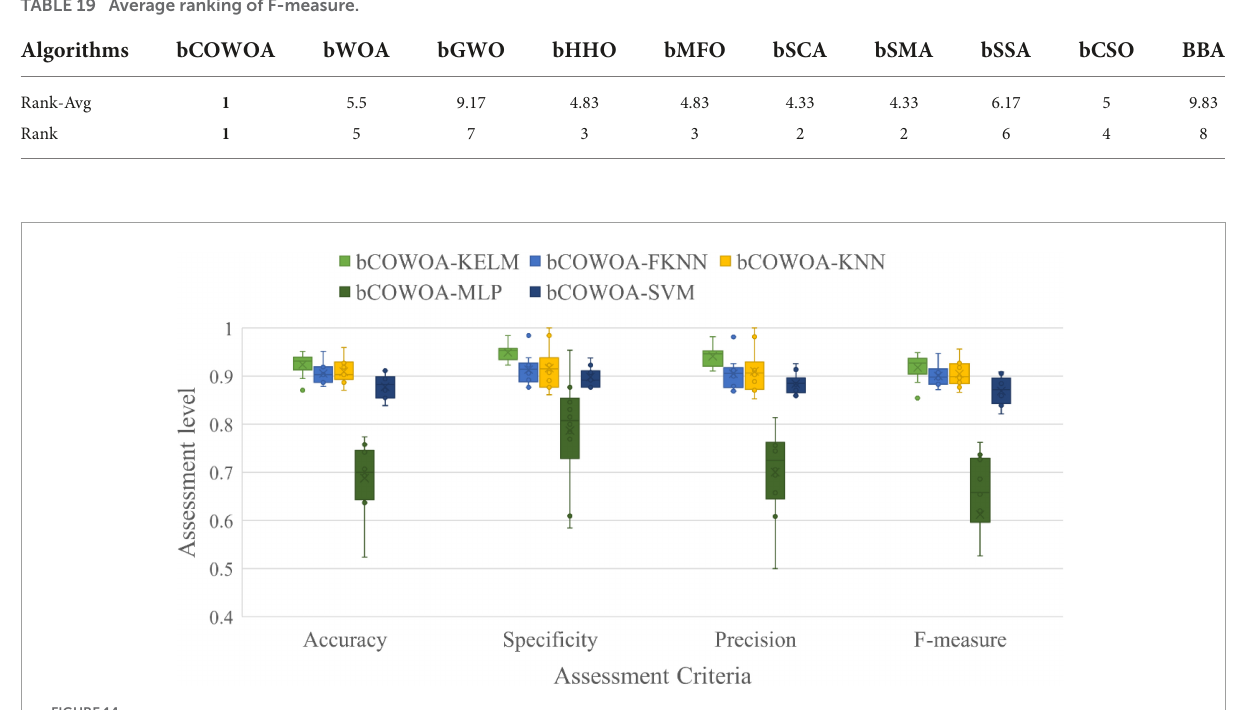
TABLE 19 Average ranking of F-measure.